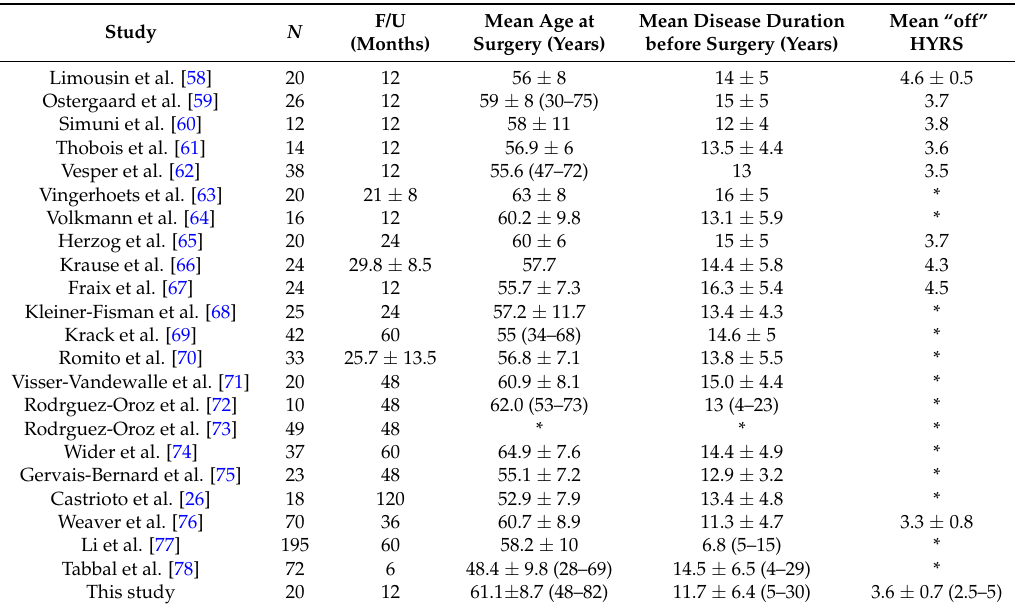
Table 6. Demographic characteristics of patients in previous studies of bilateral subthalamic nucleus stimulation in